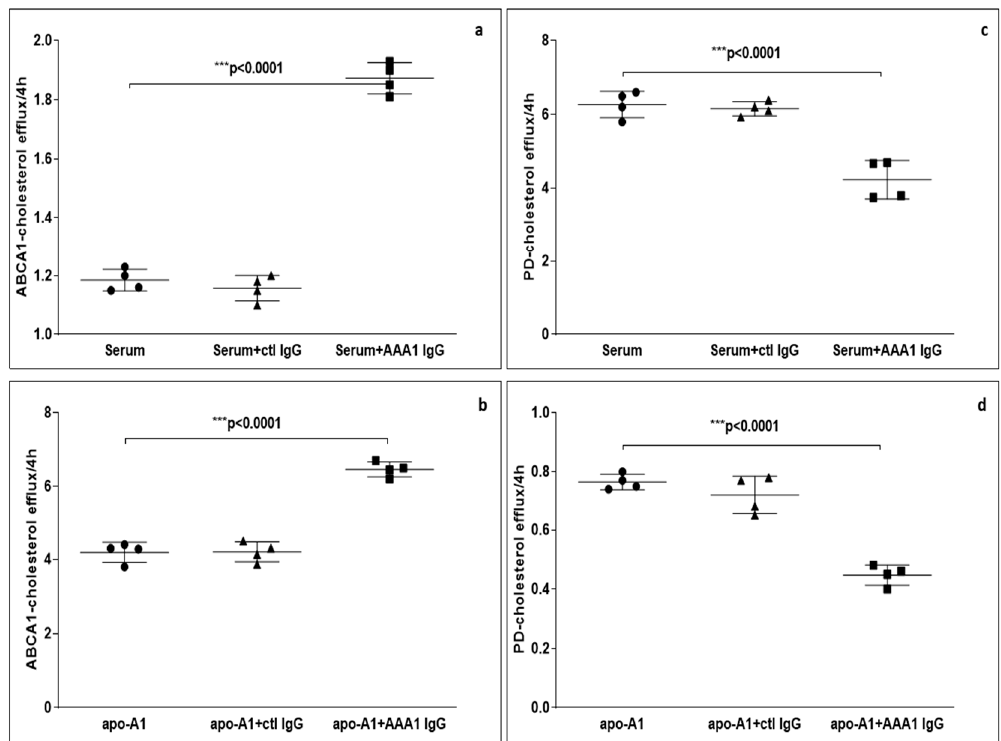
Figure 1. Cholesterol e ffl ux from J774 to various acceptors in presence of anti-apoA-1 (AAA1) IgG. ( a , b ) The cells were activated with cAMP to measure the specific e ffl ux from ABCA1 to serum or apoA-1 as acceptors after 4 h incubation. Data are expressed as the mean ± SD of the measurements done in triplicate and repeated four times ( n = 4). Statistical di ff erences were determined by one-way analysis of variance (one-way ANOVA), with p ≤ 0.05 being considered significant. ( c , d ) The cells were not activated in order to quantify the passive cellular e ffl ux di ff usion to both apoA-1 or human serum. The percentage of cholesterol e ffl ux is shown. Data are expressed as the mean ± SD of the measurements done in triplicate and repeated four times ( n = 4). Statistical di ff erences were determined by one-way analysis of variance (one-way ANOVA), with p ≤ 0.05 being considered significant.